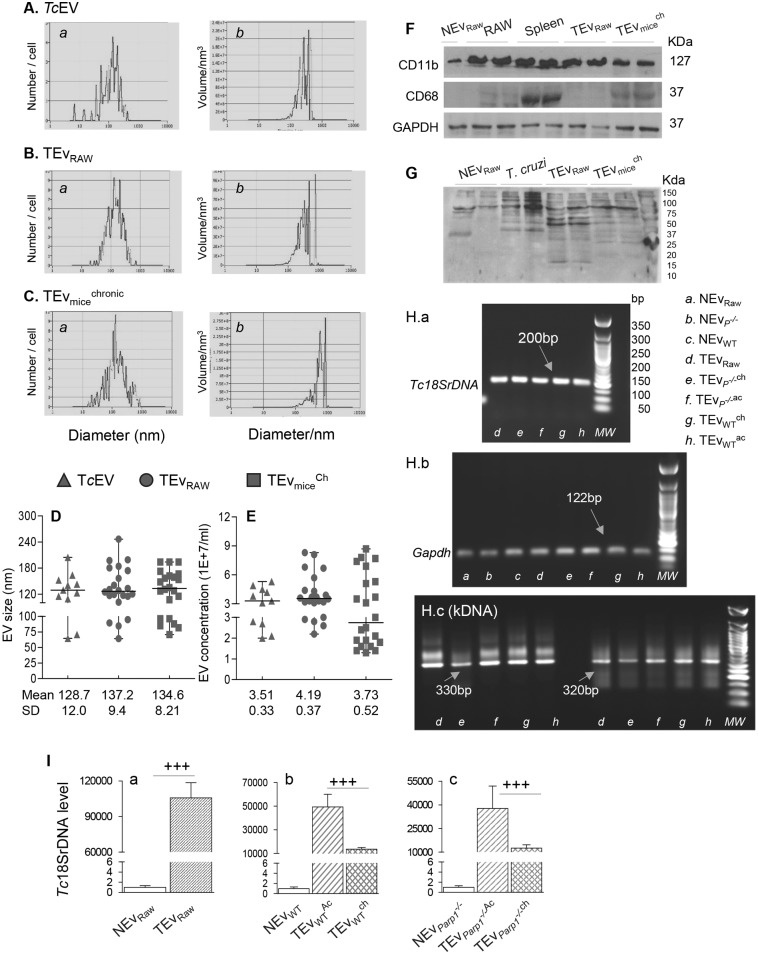
(A-E) Physical characterization of Tc-induced extracellular vesicles. Shown in A-C are representative peaks for the absolute number (panels a) and volume per nm3 (panels b) in relation to size distribution (diameter/nm) for TcEv purified from spent media of T. cruzi culture, and Ev purified from supernatants of infected RAW 264.7 Mφ (TEvRaw) and plasma of chronically infected mice (TEvmicech). Scatter dot plots for size and concentration measurements of TcEv, TEvRaw, and TEvmicech were obtained from two cycles of observations per sample, scanning 11 cell positions and capturing 60 frames. The mean and the standard deviation values for each measurement is presented below the scattered dot plots (D&E). (F&G) Protein markers by western blot analysis. Purified TEvRaw, TEvmicech and controls (NEvRaw, and Mφ, splenic, and T. cruzi lysates, 10 μg) were resolved by SDS-PAGE. Representative western blot images show CD11b, CD68 and, GAPDH levels (F) and reactivity to anti-T.cruzi polyclonal sera from infected mice (G). (H&I) PCR analysis of DNA in Ev. Total TEvDNA was purified from TEv isolated from supernatants of infected Raw Mφ and plasma of acutely (ac) and chronically (ch) infected WT and Parp1-/- mice. Real-time qPCR was performed to amplify T. cruzi-specific 18SrDNA and murine Gapdh sequences. The products of qPCR were resolved by 1.5% agarose gel electrophoresis (H, panel a). Tc18SrDNA levels normalized to mGapdh are presented as fold change ± SD (I, panels a-c) with two biological replicates each and triplicate observations per sample for panel a and n = 5 for panels b & c (vs. matched control NEv, +p<0.001). The conserved (330 bp) and variable (320 bp) regions of T. cruzi kinetoplast DNA minicircle were amplified by traditional PCR for 40 cycles and resolved by 1.5% agarose gel electrophoresis (I). NEvDNA purified from NEv of non-infected Mφ and mice were used as controls.